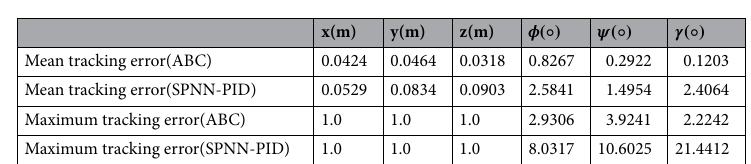
Table 5. The comparison for control statistical indicators of virtual